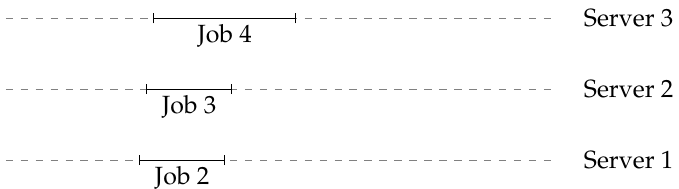
Figure 4. Assignment of jobs in the instance presented in Table 1 by Algorithm R when sampled threshold is equal to 1.1. Note that the decisions would be different if the sampling resulted in a different value of the